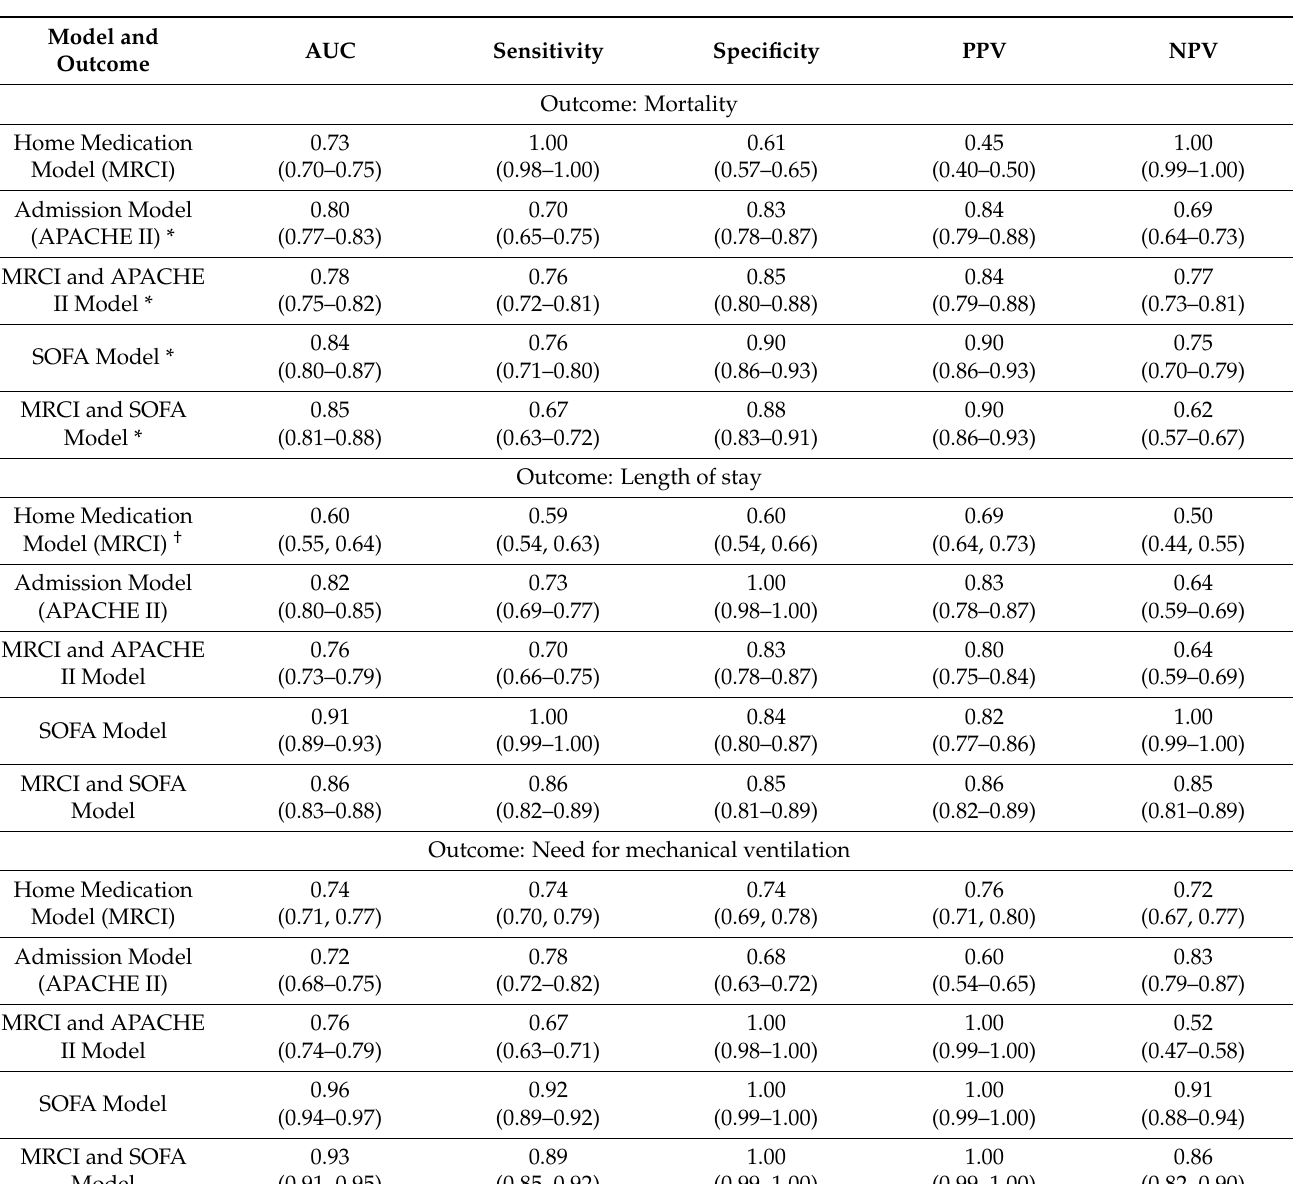
Table 4. Performance of machine learning algorithms across several models and outcomes in a subpopulation of